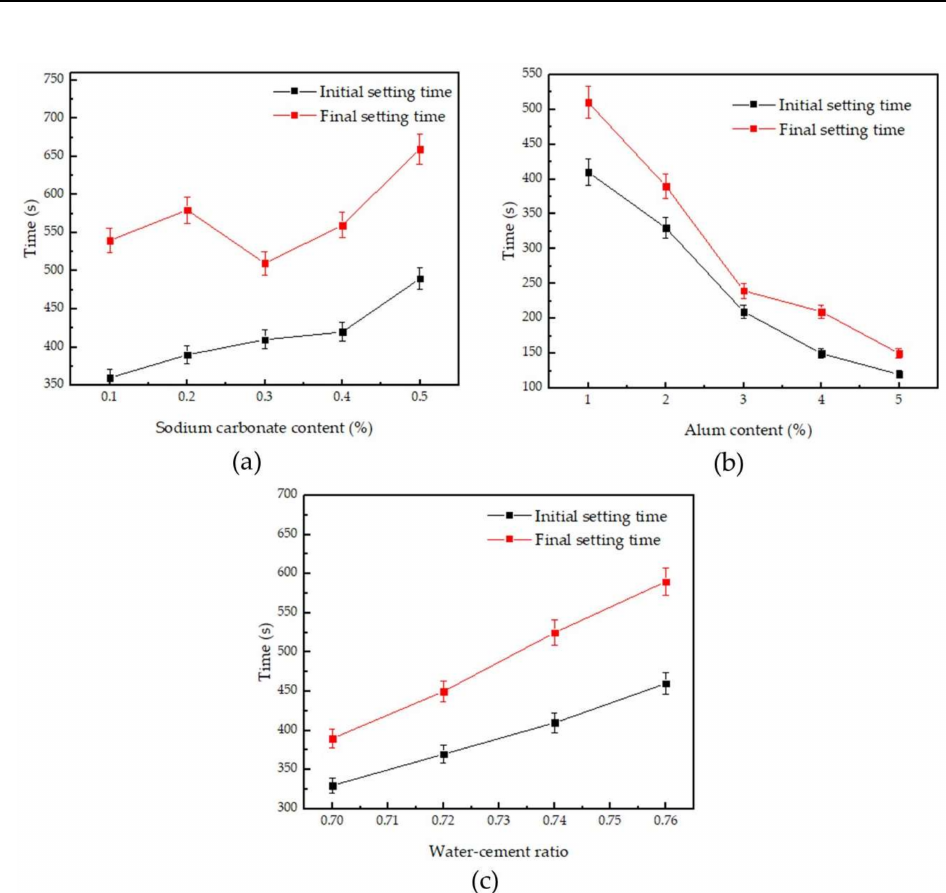
Figure 2. Effect of sodium carbonate and alum on the initial setting time and final setting time: ( a ) alum content is 1%, and sodium carbonate content changed; ( b ) sodium carbonate content is 0.3%, and alum content changed; and ( c ) sodium carbonate content is 0.3%, alum content is 2%, and the water–cement ratio